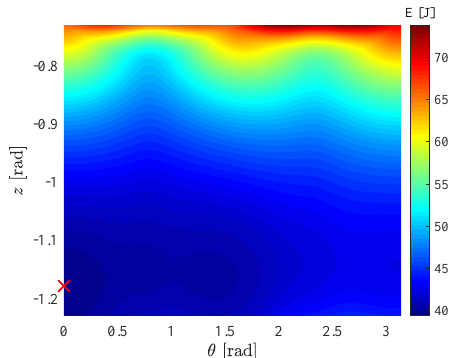
Figure 10. Energy consumption map for Case